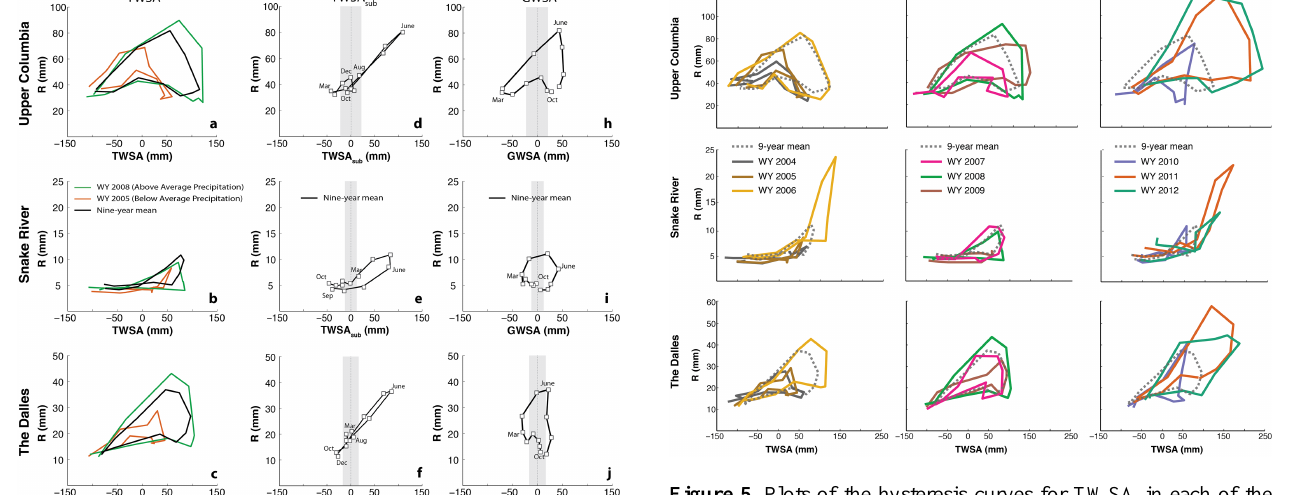
Figure 5. Plots of the hysteresis curves for TWSA in each of the three study watersheds across all 9 water years. For visual clarity, each plot contains 3 water years and the 9-year mean. Note the dif- ferent scales on the y-axes for each